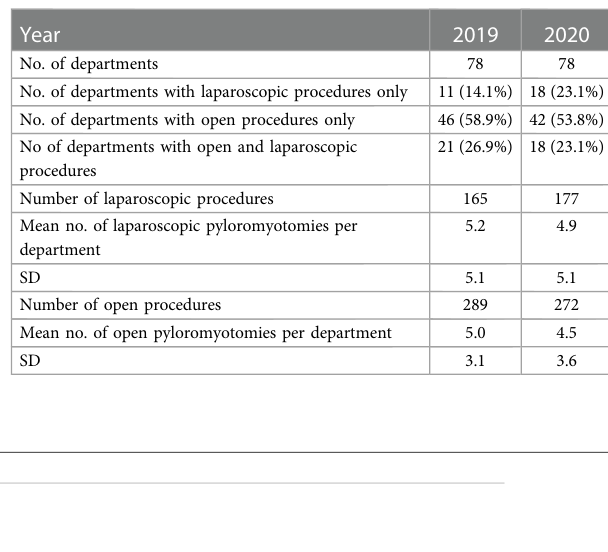
TABLE 4 Pyloromyotomies in pediatric surgical